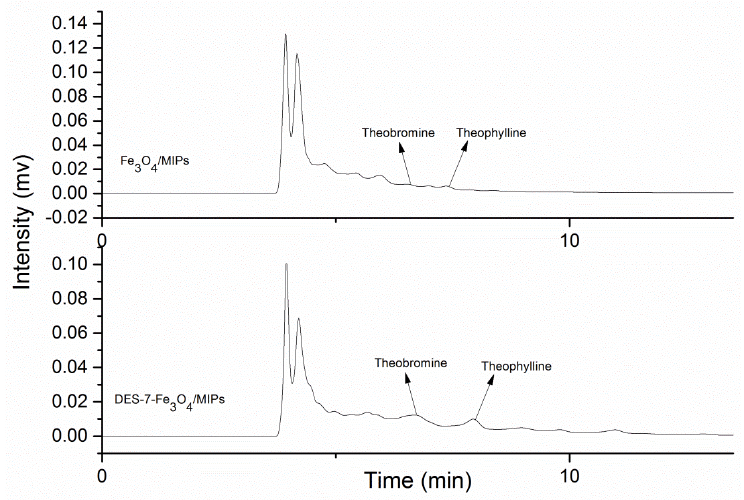
Figure 9. The purification chromatograms of green tea extracts with two materials (Fe 3 O 4 /MIPs, and DES-7-Fe 3 O 4 /MIPs) by M-SPE. (Column: C 18 column, mobile phase: methanol-water-acetic acid (20/80/2, v/v/v ), flow rate: 0.8 mL·min − 1 , UV: 280 nm, injection: 10 μ L).